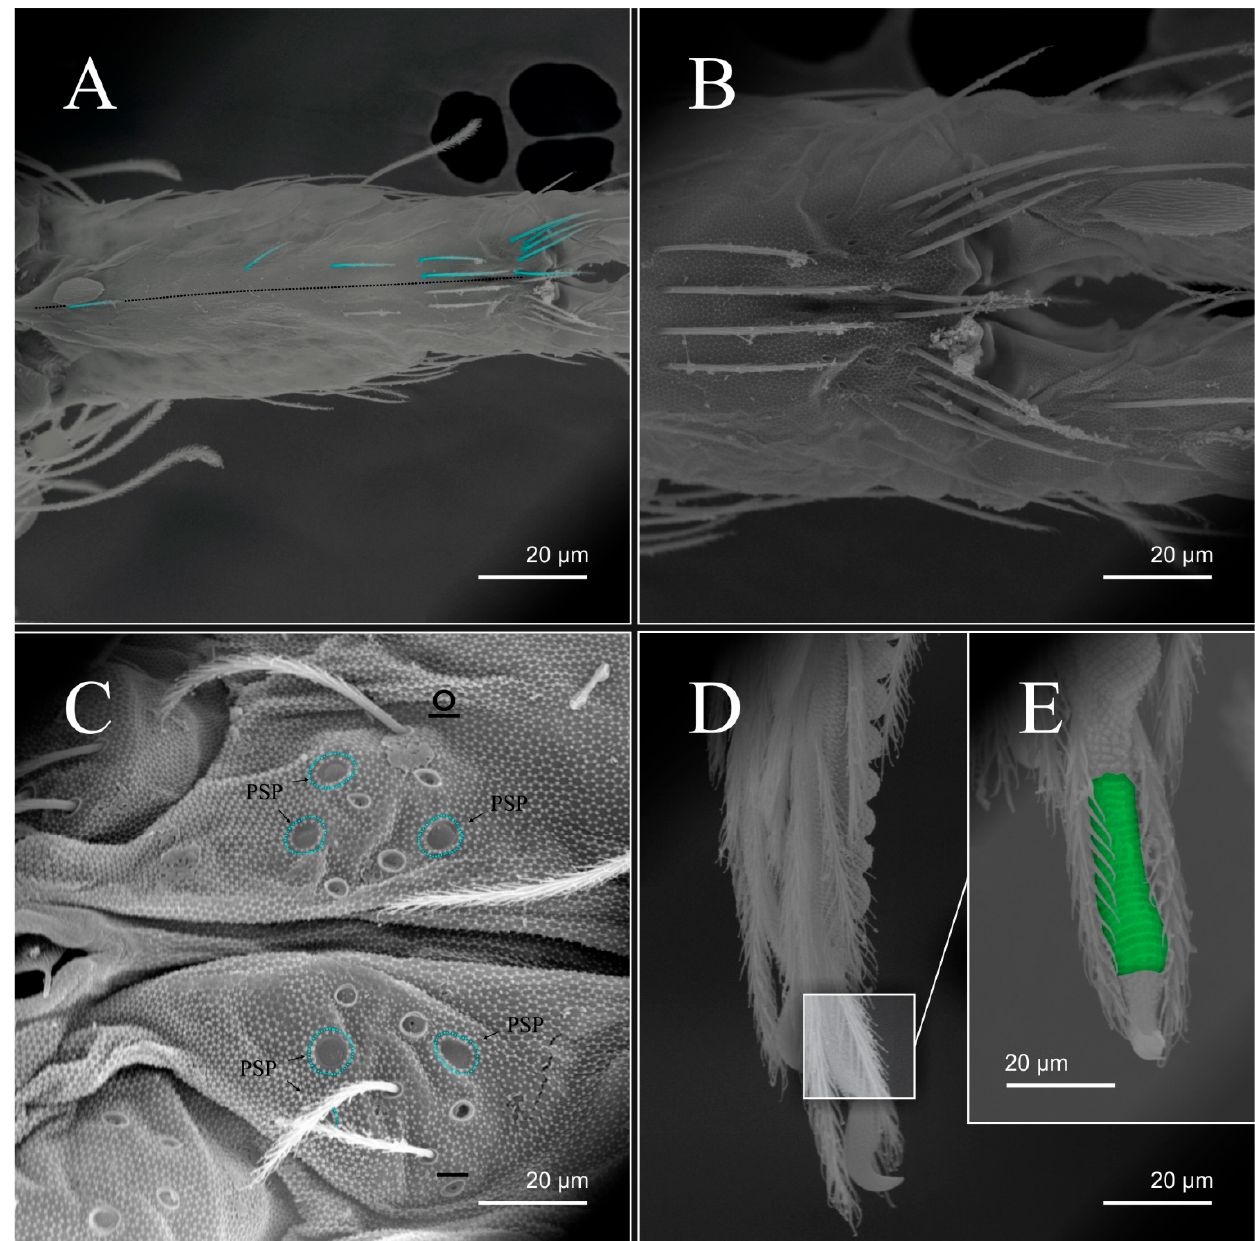
Figure 14. Seira musarum SEM: furca: ( A ), ventral manubrium, ( B ), manubrium ventral distally; ( C ), manubrial plate; ( D ), dens distally and mucro; ( E ), details of the dens distally and mucro. Paronellidae Börner, 1913 Brazilian Oceanic Island Records: RA (3 ◦ 51 (cid:48) 32.38 (cid:48)(cid:48) S; 33 ◦ 48 (cid:48) 56.96 (cid:48)(cid:48) W), SF, 08 Oct 2015, E. C. A. Lima leg., CRFS #15079—15081. SPSP (0 ◦ 54 (cid:48) 59.98 (cid:48)(cid:48) N; 29 ◦ 20 (cid:48) 44.03 (cid:48)(cid:48) W), SB, 25 Apr 2017, E. C. A Lima & D. Zeppelini leg., CRFS #15083, #15085, #15088. SPSP (0 ◦ 54 (cid:48) 59.74 (cid:48)(cid:48) N; 29 ◦ 20 (cid:48) 44.57 (cid:48)(cid:48) W), SF, 24 Apr 2017, E. C. A Lima & D. Zeppelini leg., CRFS #15084, #15087. SPSP (0 ◦ 55 (cid:48) 1.00 (cid:48)(cid:48) N; 29 ◦ 20 (cid:48) 45.60 (cid:48)(cid:48) W), SF, 26 Apr 2017, E. C. A Lima & D. Zeppelini leg., CRFS #15086. FN (3 ◦ 51 (cid:48) 3.73 (cid:48)(cid:48) S; 32 ◦ 26 (cid:48) 0.38 (cid:48)(cid:48) W), SF, 27 Jul 2012, E. C. A. Lima & A. S. Ferreira Leg., CRFS #15117, #15118, #15121. FN (3 ◦ 50 (cid:48) 44.85 (cid:48)(cid:48) S; 32 ◦ 25 (cid:48) 44.80 (cid:48)(cid:48) W), SF, 17 Jul 2008, D. Zeppelini leg., CRFS #15119, #15120,